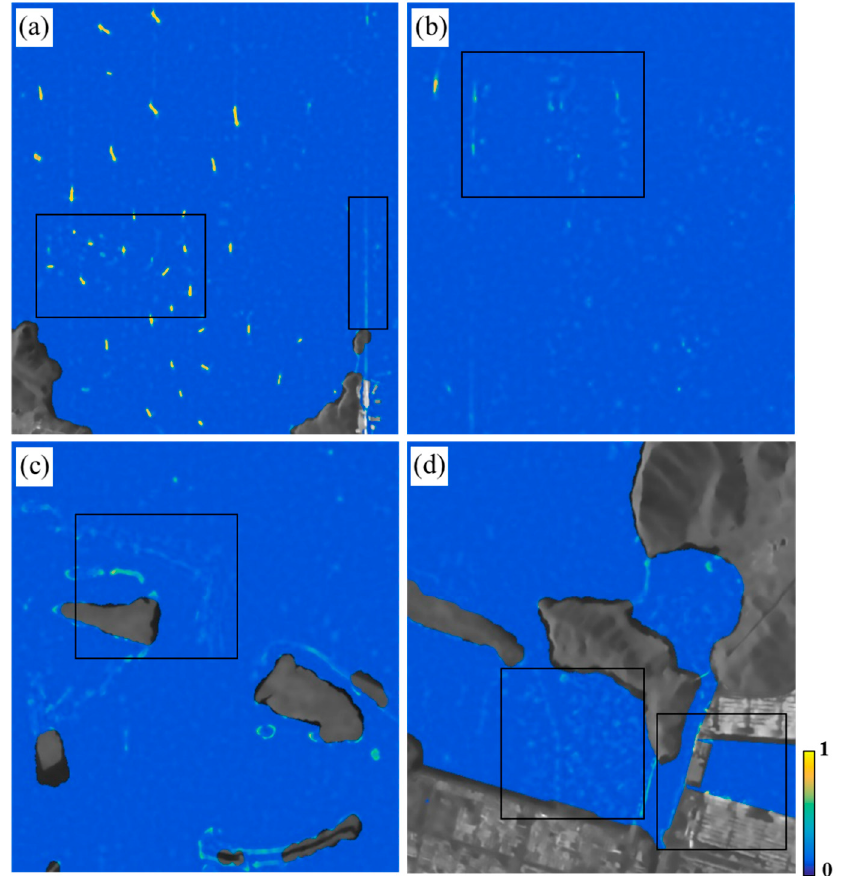
Figure 6. ( a – d ) The ship-probability maps magnified from the A to D boxes in Figure 5.